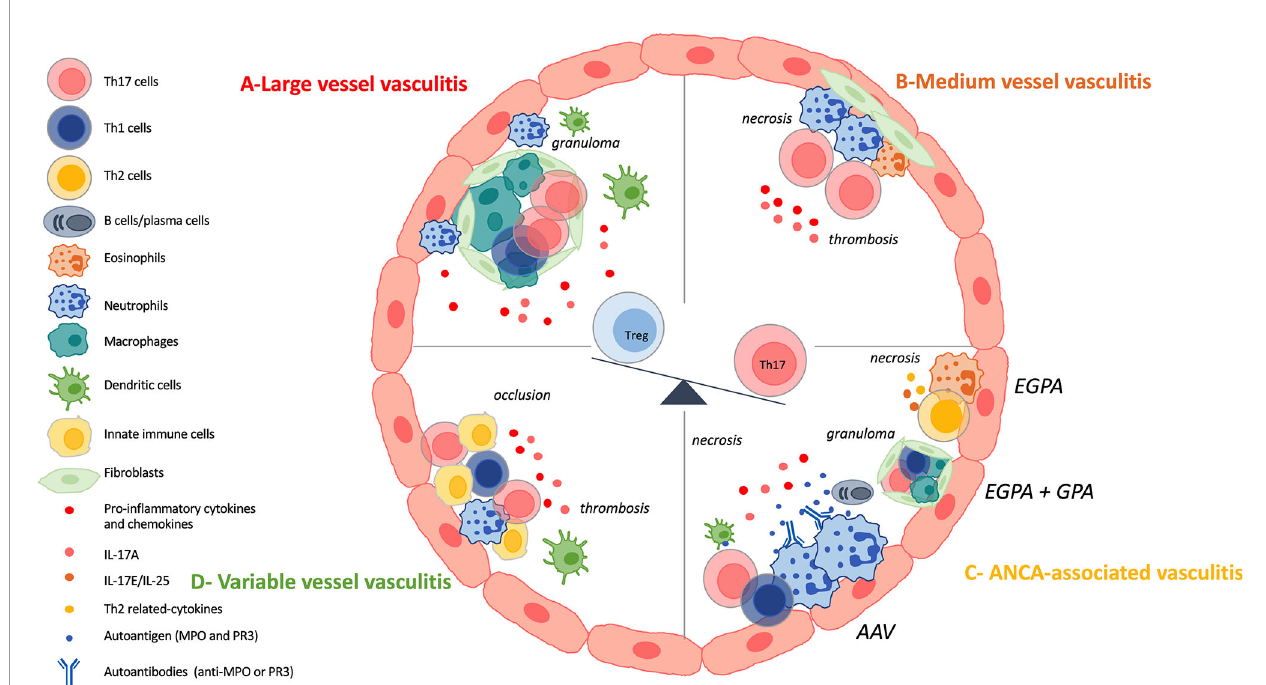
FIGURE 3 | IL-17 and Th17 involvement in vasculitis. (A) : Large vessel vasculitis (LVV) include giant cell arteritis (GCA) and Takayasu arteritis (TAK) and are characterized by a chronic granulomatous in fl ammatory reaction. Vascular adventitial dendritic cells are activated and induce the recruitment, the activation and the polarization of CD4 + T cells. Among CD4 + T cells, T-helper (Th)-17 cells and Th1 cells are involved in the local in fl ammatory process. Then, CD8 + T cells and monocytes are recruited and fi nally, vascular remodeling occurs. Th17 cells are also circulating and patients harbor increased frequency of them. IL-17A promotes neutrophil recruitment. There is a decrease of regulatory T (Treg) cells at the expense of the Th17 lineage. (B) : Medium vessel vasculitis (MVV) comprise polyarteritis nodosa (PAN) and Kawasaki disease (KD). There are few data on Th17 involvement in PAN pathogenesis but patients harbor defective Tregs and increased frequency of Th17 cells. KD is characterized by necrotizing arteritis with neutrophil in fi ltration. Lymphocytes, eosinophils and myo fi broblastic proliferation participate in KD arteriopathy. Th17 cells and their related cytokines are increased in KD and there is a dysregulation of the Th17/Treg balance. (C) : Antineutrophil cytoplasmic antibody (ANCA)-associated vasculitis (AAV) are composed of three variants: microscopic polyangiitis (MPA), granulomatosis with polyangiitis (GPA), eosinophilic granulomatosis with polyangiitis (EGPA). They are characterized by fi brinoid necrosis, thrombus formation and immune cell in fi ltration. GPA and EGPA are associated with granulomatous in fl ammatory reaction where Th17, Th1 cells and macrophages play a role. EGPA is characterized by the involvement of eosinophils, Th2 cells and their related cytokines. GPA and MPA, and sometimes EGPA, are associated with ANCA. There is a loss of B and T tolerance toward MPO and PR3 antigens, that are found primary in neutrophils. PR3 and MPO-speci fi c Th17 responses occur in the course of the disease. IL-17A also favors the recruitment of neutrophils at the site of injury. There is a dysregulated Th17/Treg cells balance. (D) : Variable vessel vasculitis (VVV) can affect any type and any size of vessels. Enhanced innate immune response, early tissue in fi ltration and late adaptive immunity are the different steps that occurred in Behc ̧ et ’ s disease (BD) pathogenesis. This results in thrombosis, occlusion and aneurysms. Th17 cells are found at the site of tissue injury and interact with other immune cells. There is an hyperactivation of Th17 and Th1 cells at the expense of Treg